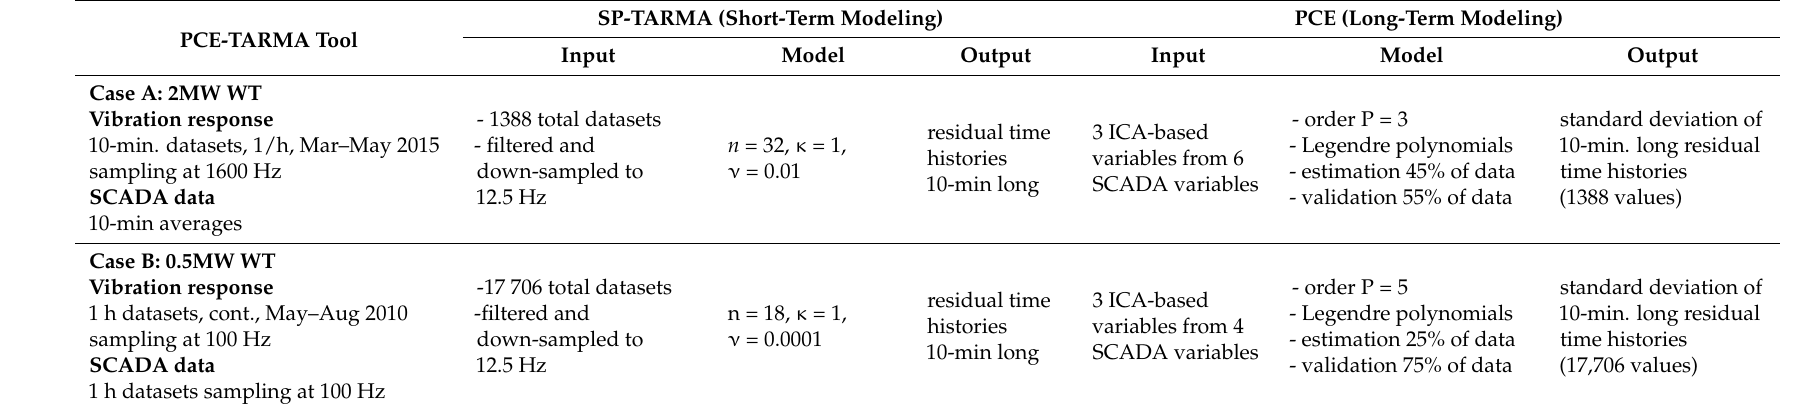
Table 2. Summary of the applied bi-component tool for the two case